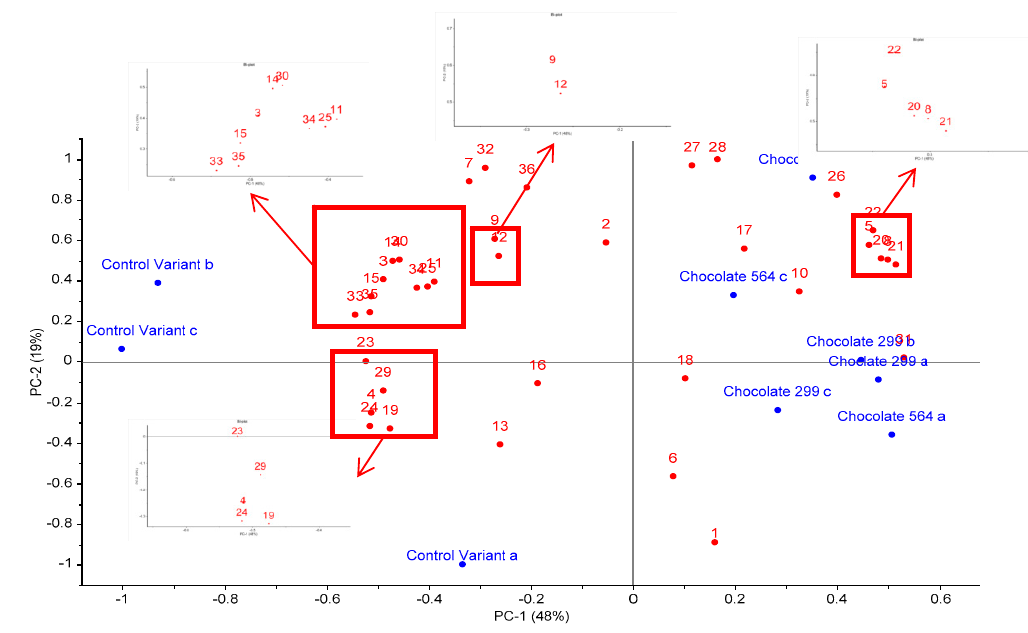
Figure 2. Principal component analysis (PCA) bi-plot of volatile compounds detected in dark chocolate with and without probiotic bacteria. Compounds are: 1. ethanol, 2. acetone, 3. isobutanal, 4. butanone, 5. 3-methyl-butanal, 6. acetic acid, 7. acetoin, 8. hexanal, 9. 2,3-butanediol, 10. isoamyl acetate, 11. 1,6-heptadien-4-ol, 12. isovaleric acid, 13. 2-heptanone, 14. 2-methyl-butanoic acid,